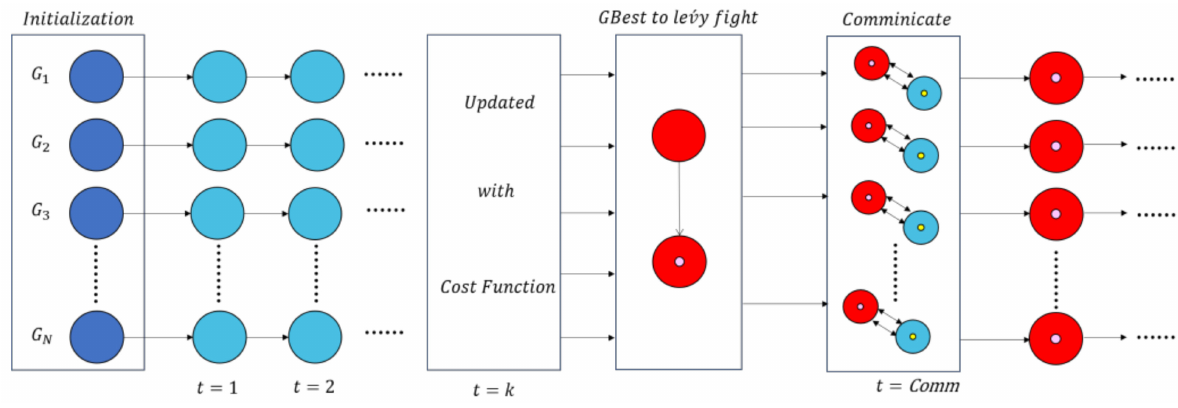
Figure 1. The PL-AOA algorithm